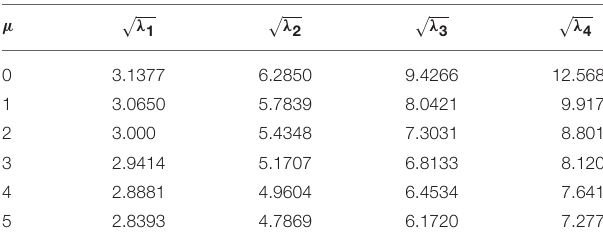
√ λ for SS case for different nonlocal (cid:16) (cid:17)